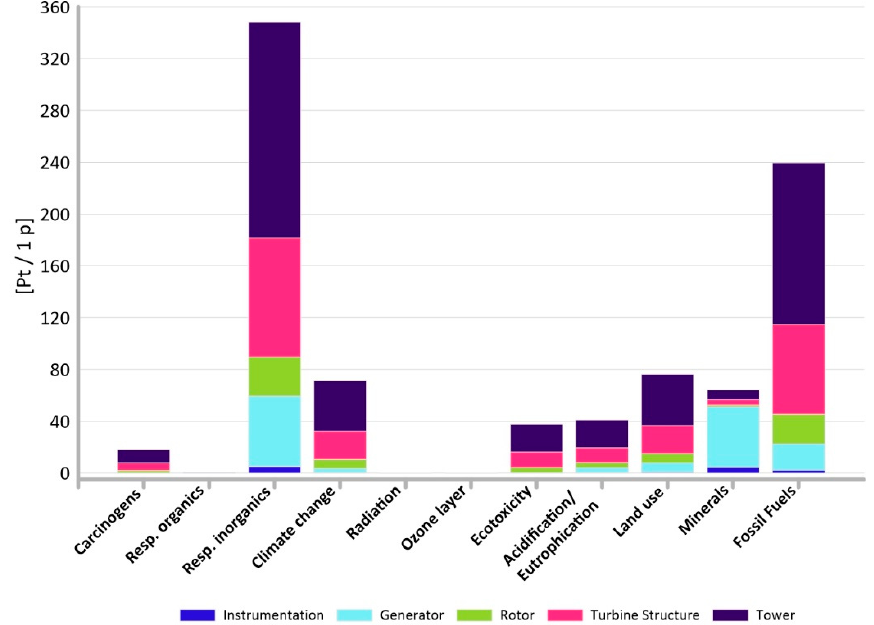
Figure 5. Comparison of results of grouping and weighting of particular impact categories for elements of an innovative power plant—methods without recycling.